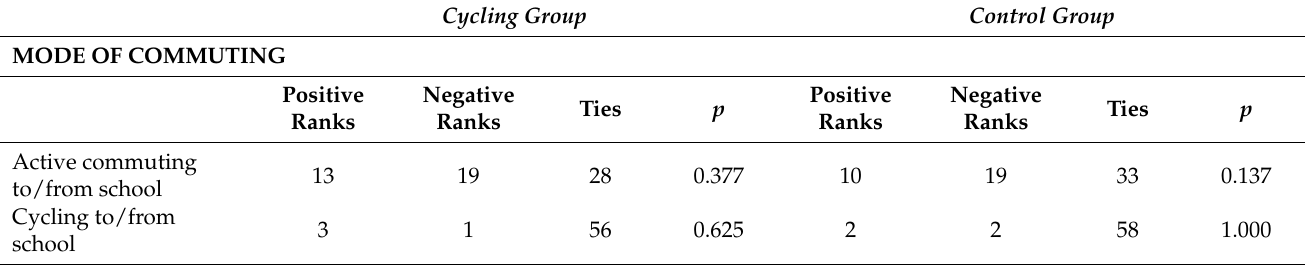
Table 3. Changes in the mode of commuting to/from school and children’s perceived barriers to ACS at baseline and at follow up of the school-based intervention for both groups (per protocol